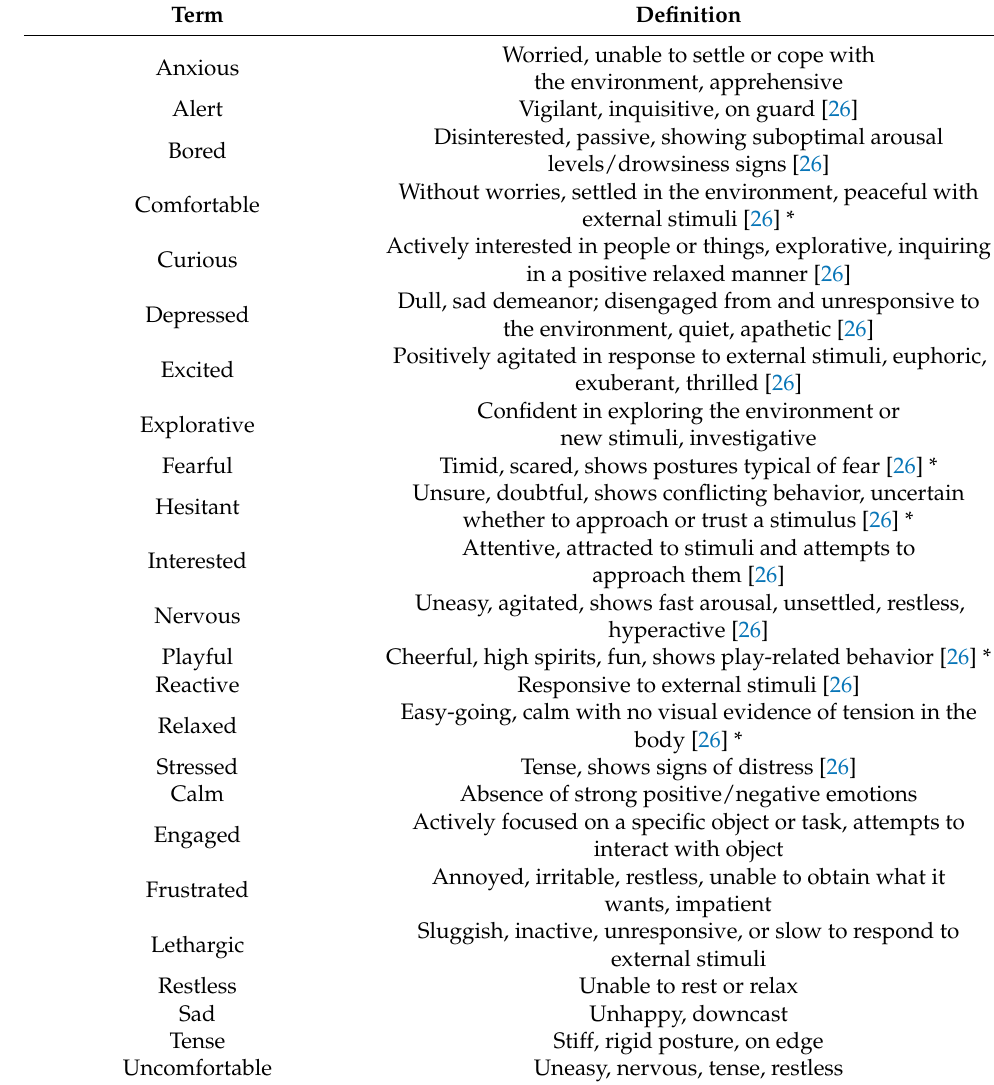
Table 2. Qualitative Behavioral Assessment (QBA) used to measure dog behavior at 5 min intervals during test